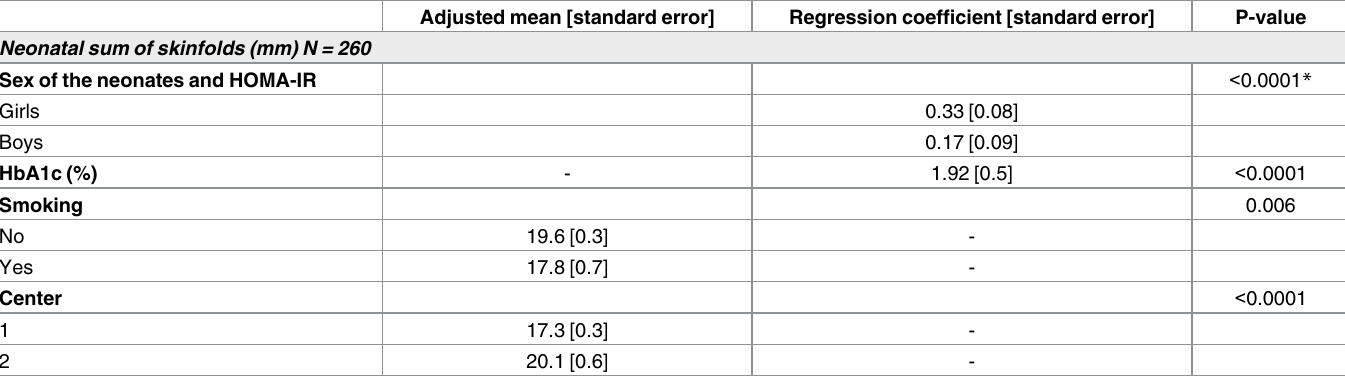
Table 4. Multivariate analysis on skinfolds including HOMA-IR performed at 37 weeks in the model. The analysiswas performed on data from 136 N and 124 Ob women. Data are presented with adjustedmean [standarderror] for categorical variables or regressioncoefficient[standard error] for continuous variables. Only significantdata are presented.